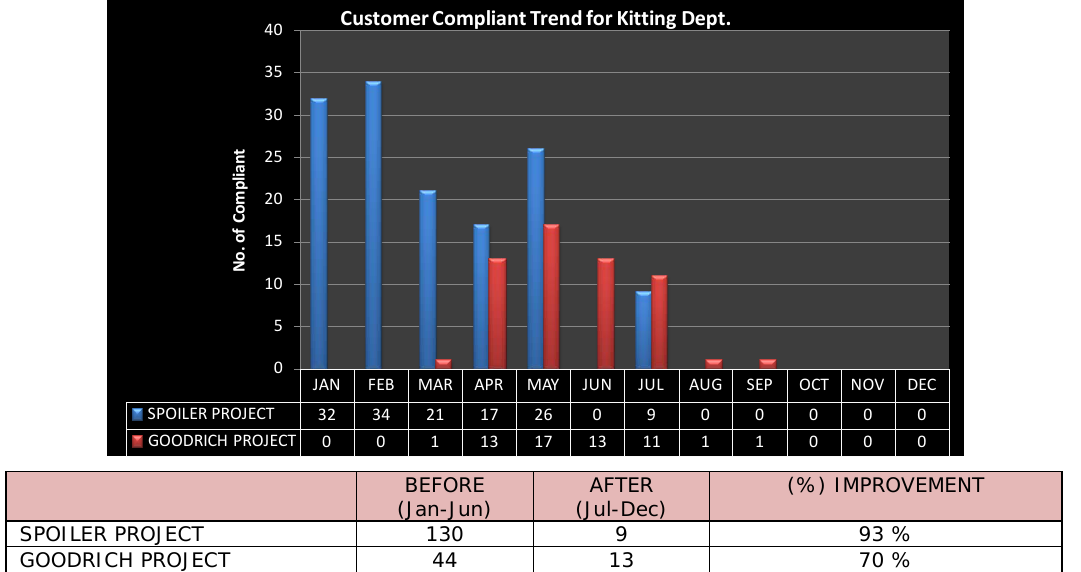
Figure 8. “Percentage of improvement for Customer Complaint PM”.